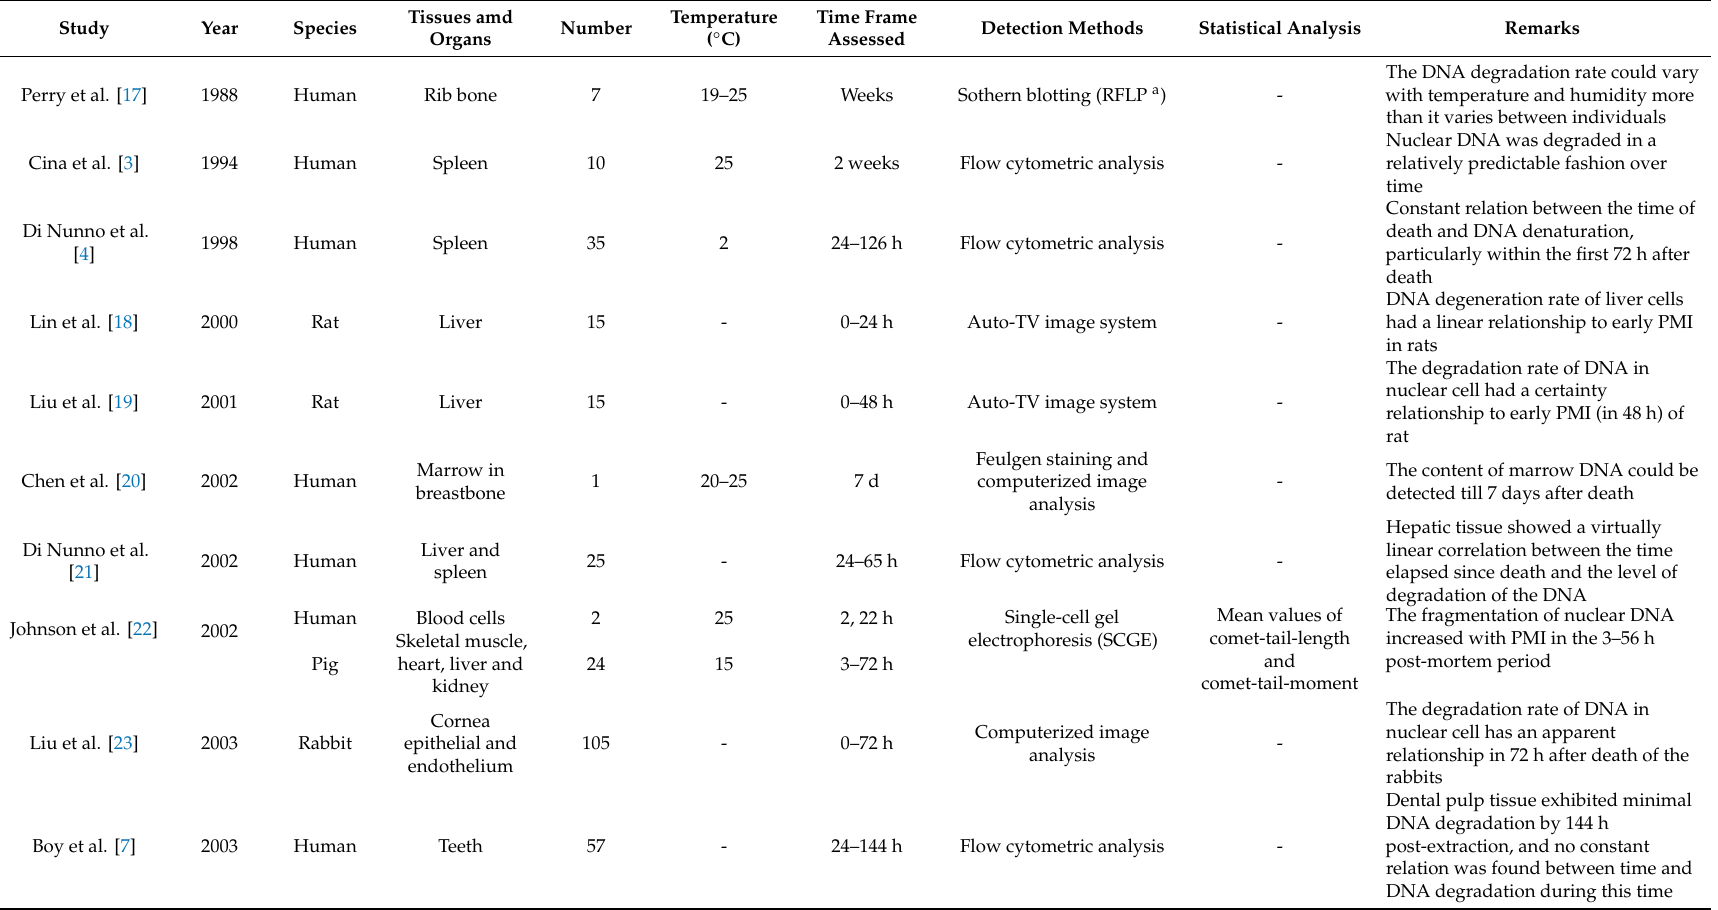
Table 1. Correlation between DNA degradation and post-mortem interval (PMI) at di ff erent